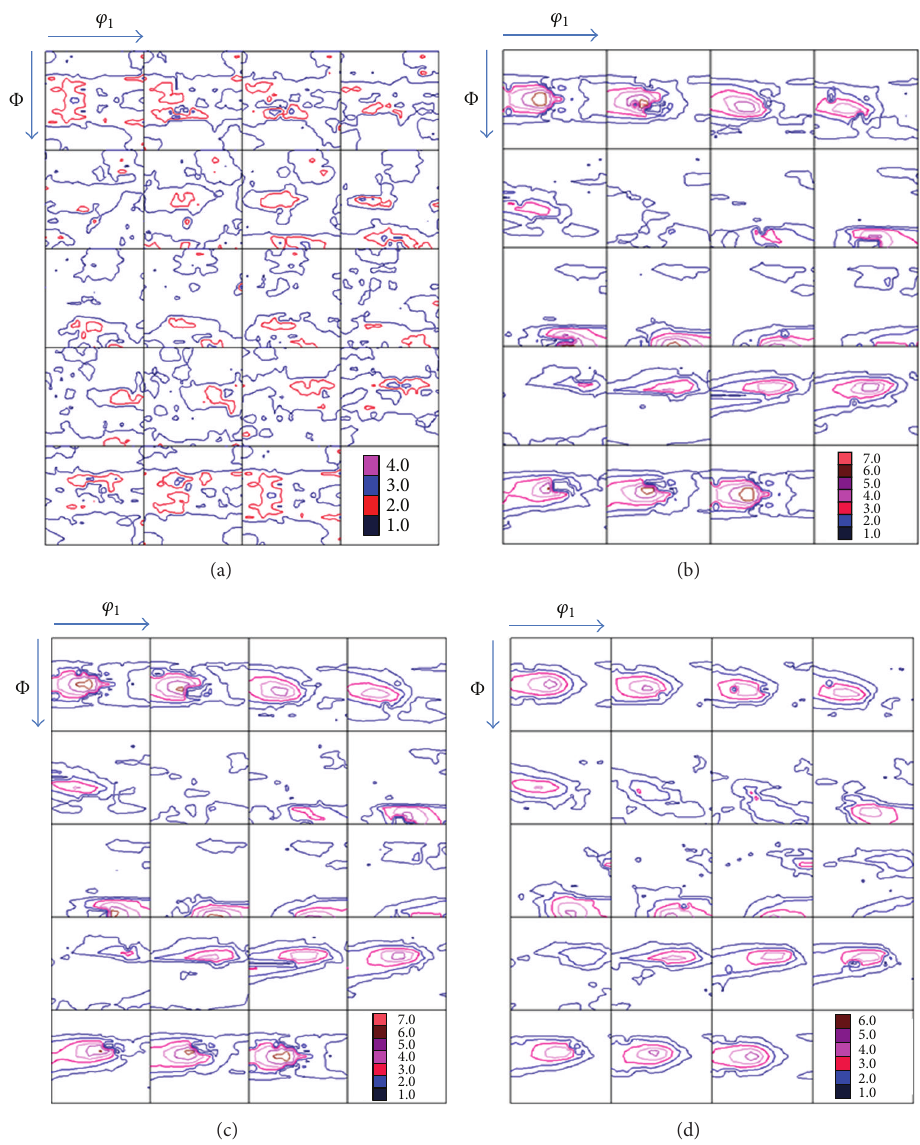
Figure 3: (a) Orientation distribution function (constant 𝜑 2 sections) of hot rolled sample. (b) Orientation distribution function (constant 𝜑 2 sections) of R1 sample. (c) Orientation distribution function (constant (constant 𝜑 2 sections) of R3 sample.